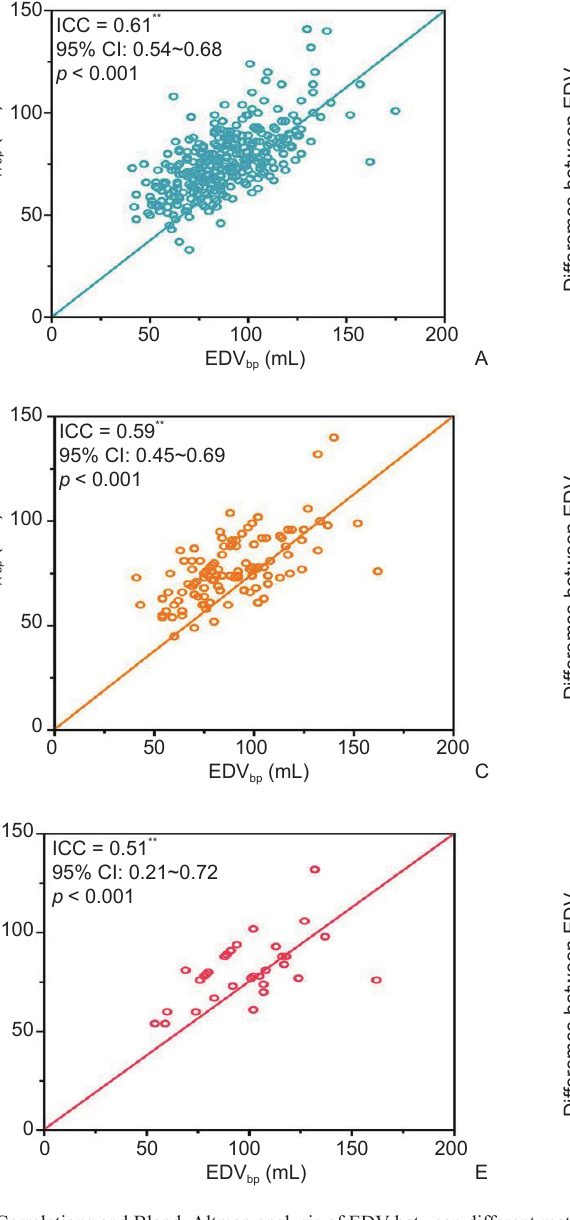
Figure 4 Correlations and Bland–Altman analysis of EDV between different methods. (left) Correlation plots and (right) Bland–Altman plots for manual EDV vs. automated EDV in the common group (A and B), CHD group (C and D), WMA group (E and F). CHD, cardiac heart disease; WMA, wall motion abnormalities; ICC, intraclass correlation coefficients; CI, confidence interval; 95% LoA, 95% limits of agreement; EDV, end-diastolic volume; EDV bp was parameter by manual method; EDV A-bp was parameter by automated